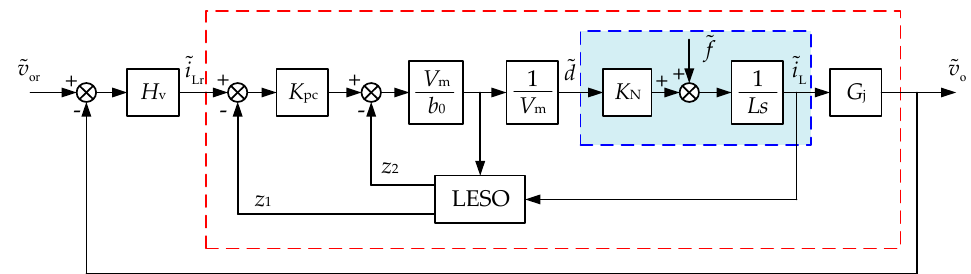
Figure 4. The control block diagram of a DSBB converter with the proposed dual loop control.